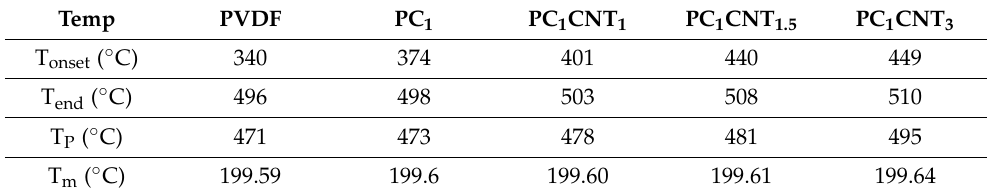
Table 2. TGA, DTA, and DSC temperatures of pure and nano-fillers loaded PVDF nanocomposites. Temp PVDF PC 1 PC 1 CNT 1 PC 1 CNT 1.5 PC 1 CNT 3 T onset ( ◦